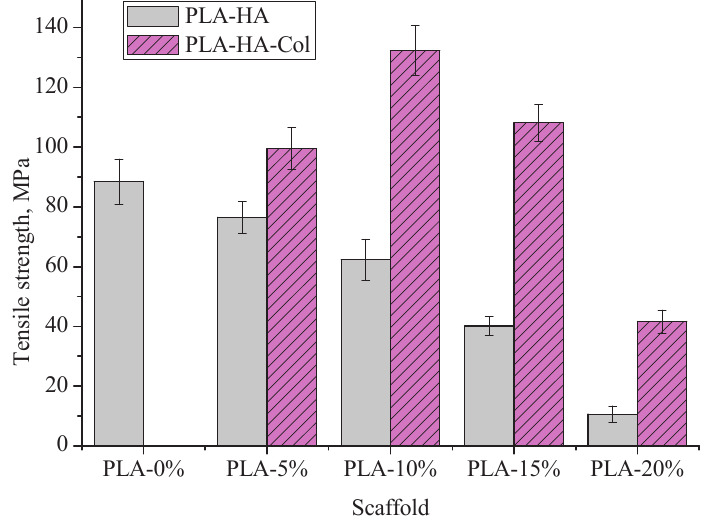
Figure 9: Tensile strength of scaffold containing HA and HA grafted